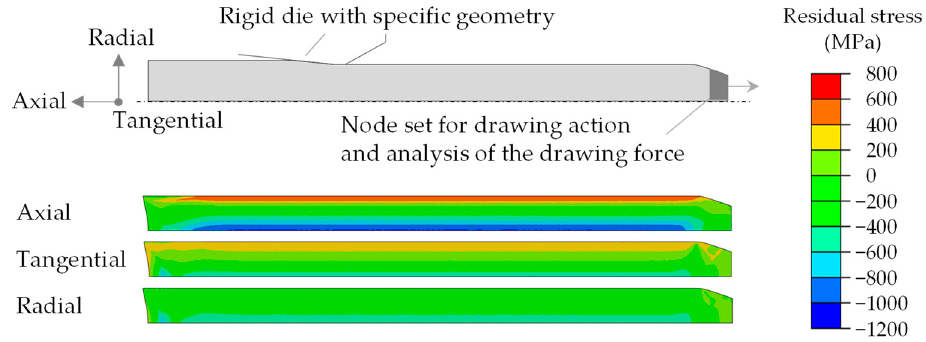
Figure 5. FE model setup and residual stresses after wire drawing (example conventional geome- try).